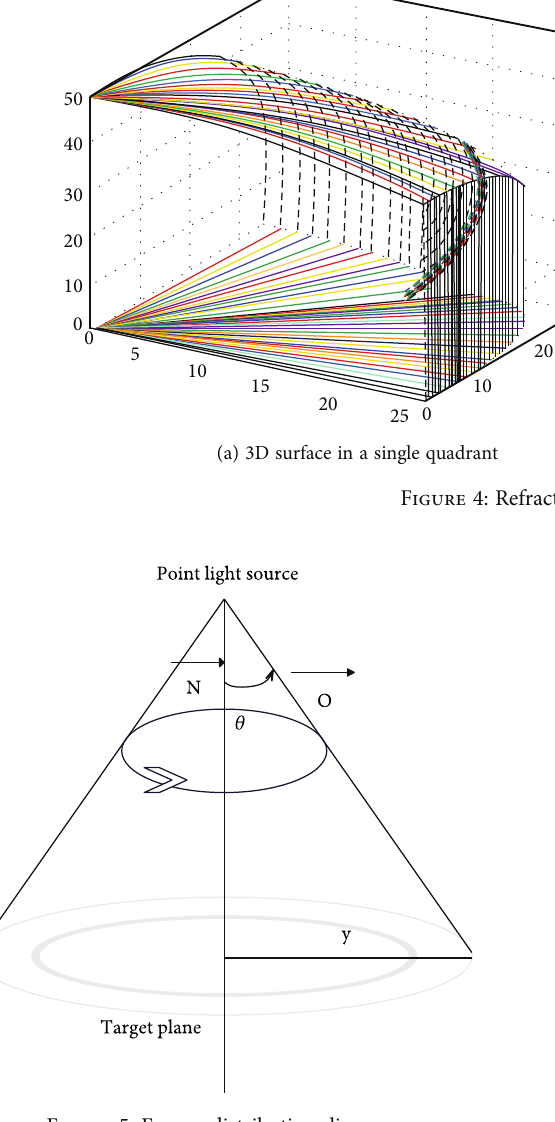
Figure 5: Energy distribution diagram.